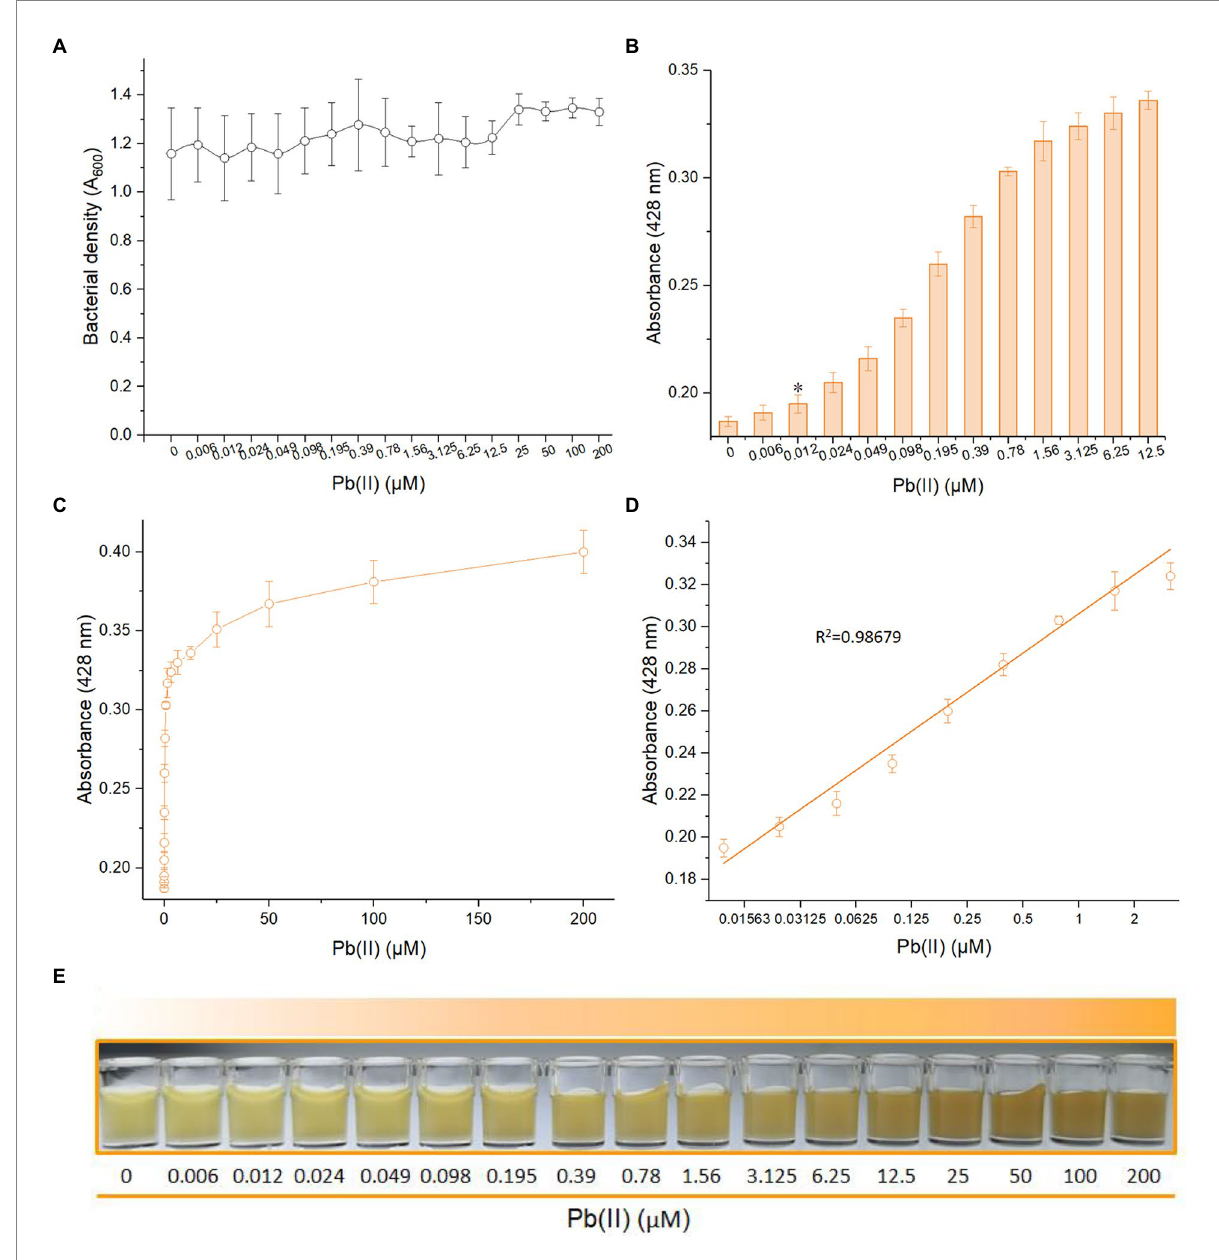
FIGURE 4 Response of TOP10/pPb-CACD to increased concentrations of Pb(II). TOP10/pPb-CACD was inoculated into fresh LB medium supplemented with 1 mM catechin and induced with increased concentrations of Pb(II) at 37 ° C overnight. The cell-free culture supernatants containing CACD were prepared and detected by visible light absorbance at 428 nm. (A) Bacterial densities of TOP10/pPb-CACD exposed to different concentrations of Pb(II). (B) The detection sensitivity of TOP10/pPb-CACD. Data represent the average of three independent assays with similar results. Error bars represent standard deviations. The asterisk represents the limit of detection, which is adopted as the lowest concentration of Pb(II) that triggered a significant increase of absorbance value at 428 nm (background +3 × SD). (C) The dose–response curve with Pb(II) concentration ranges from 0 to 200 μ M. (D) Regression analysis of the relationship of pigment-based signal and the Pb(II) concentrations ranging from 0.012 to 3.125 μ M. The x -axis displays the Pb(II) concentration on the log 2 scale. Data shown are mean ± SD ( n =3). (E) A representative picture of the cultures induced with increased concentrations of